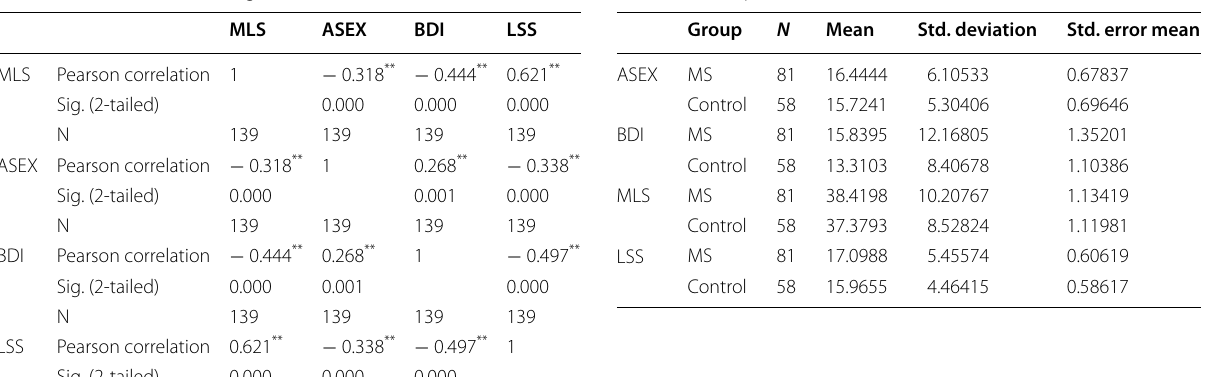
Table 4 Correlations among scales Table 5 Group statistics for ASEX, BDI, MLS,